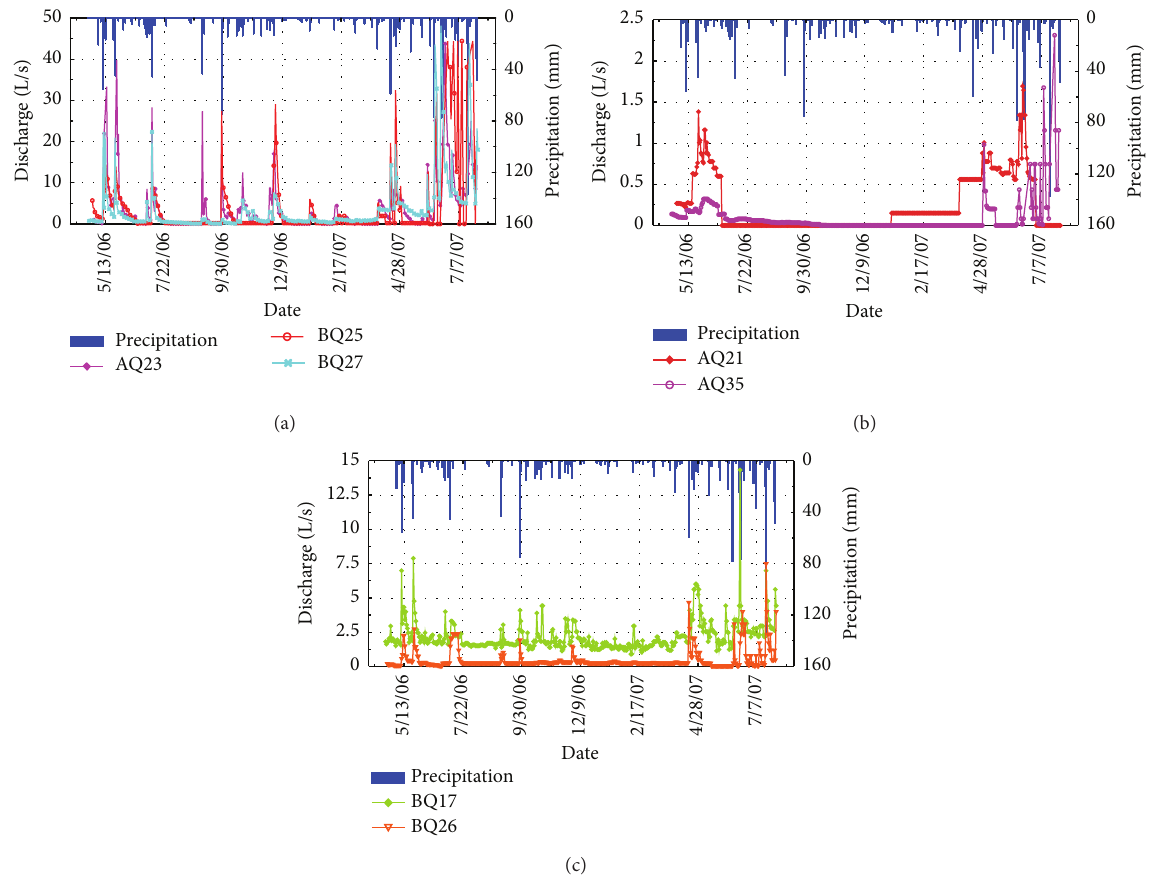
Figure 4: Hydrographs of the principal springs in the project area. (a) Discharge of AQ23, BQ25, and BQ27 versus time. (b) Discharge of AQ21 and AQ35 versus time. (c) Discharge of BQ26 and BQ27 versus time.